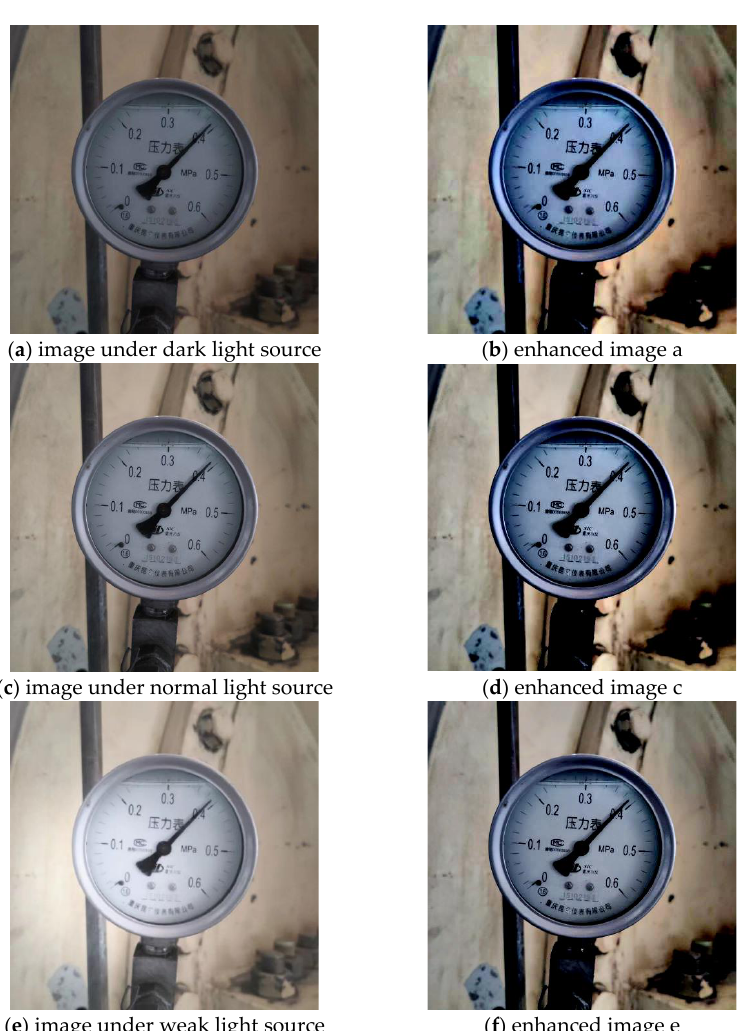
algorithm. In Figure 8, the light source of the first two images is dark, the light source of the middle two images is normal and the light source of the last two images is weak.